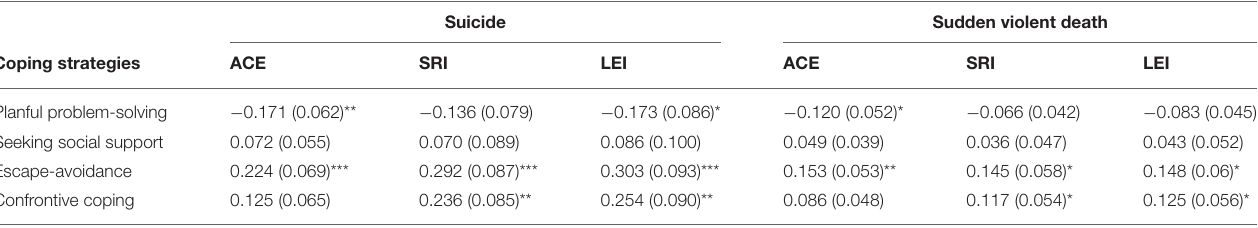
TABLE 4 | Mediated/indirect effects (and standard errors), adjusted for age, of group membership (suicide and sudden violent death vs. controls) on coping via life events (ACE, SRI, and